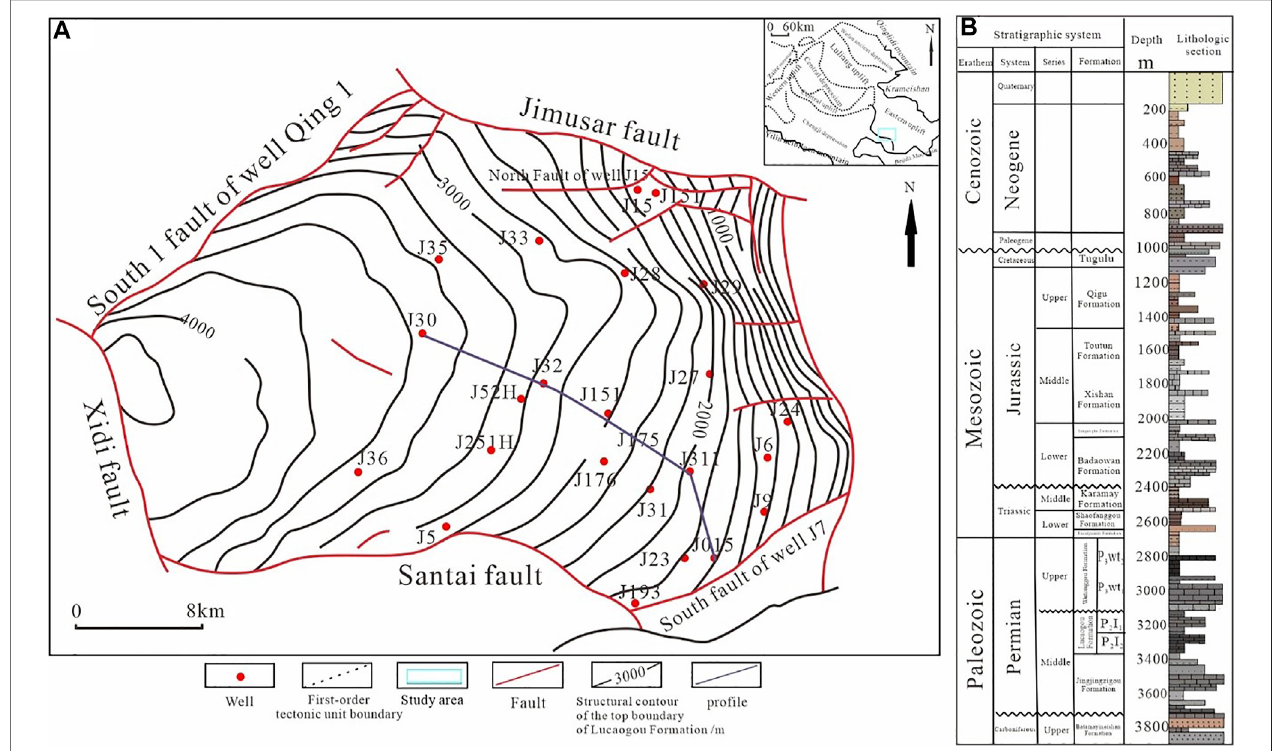
FIGURE 1 | Schematic diagram of the work area location. Geological structure map of Jimusar depression (A) . Lithologic Histogram of Jimusar Depression (B) .